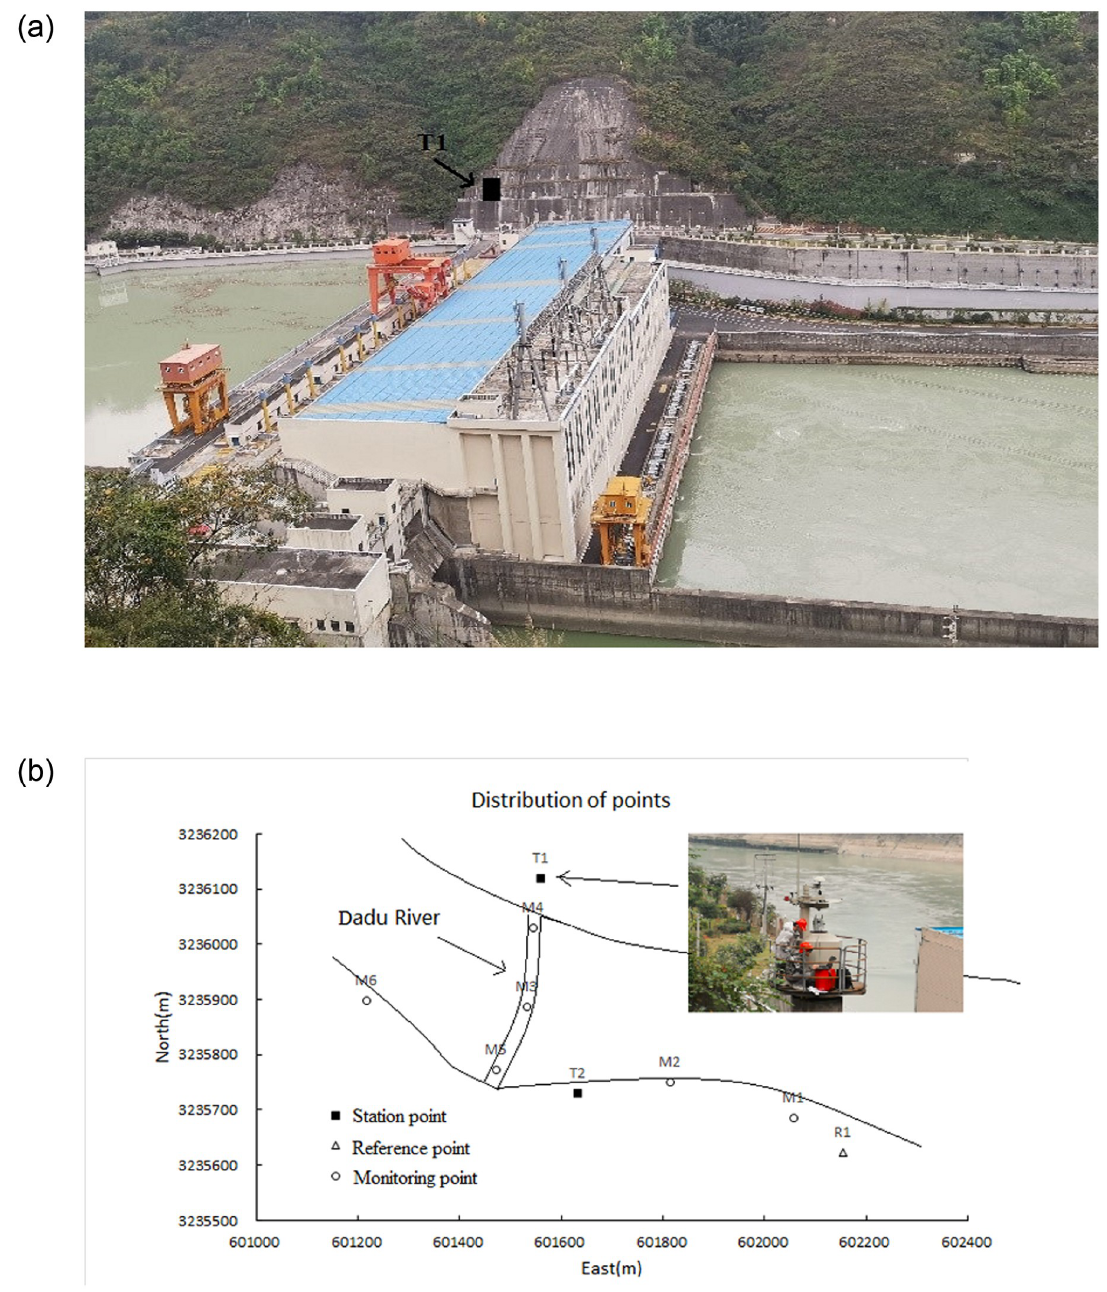
Fig 8. Refraction correction test in Zhentouba I hydropower station. (a) Zhentouba I hydroelectric dam. (b) Distribution of points in test. https://doi.org/10.1371/journal.pone.0251281.g008 7–8 mm in the theoretical situation assuming no refraction. When the raw observations were used to directly calculate the plane displacements of monitoring points, the MSEs increased several times compared to the theoretical situation. Overall, the plane displacement accuracy of monitoring points was improved when coordinate correction was conducted with each of the four reference points. For some monitoring points, the plane displacement accuracy after